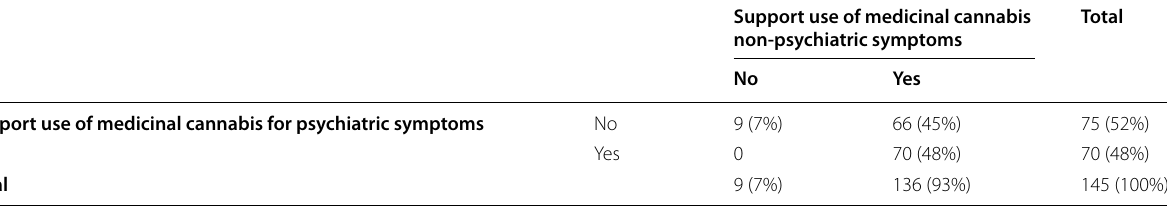
Table 2 Distribution of frequencies and percentages regarding the support of use of MC for psychiatric and non‑psychiatric symptoms among